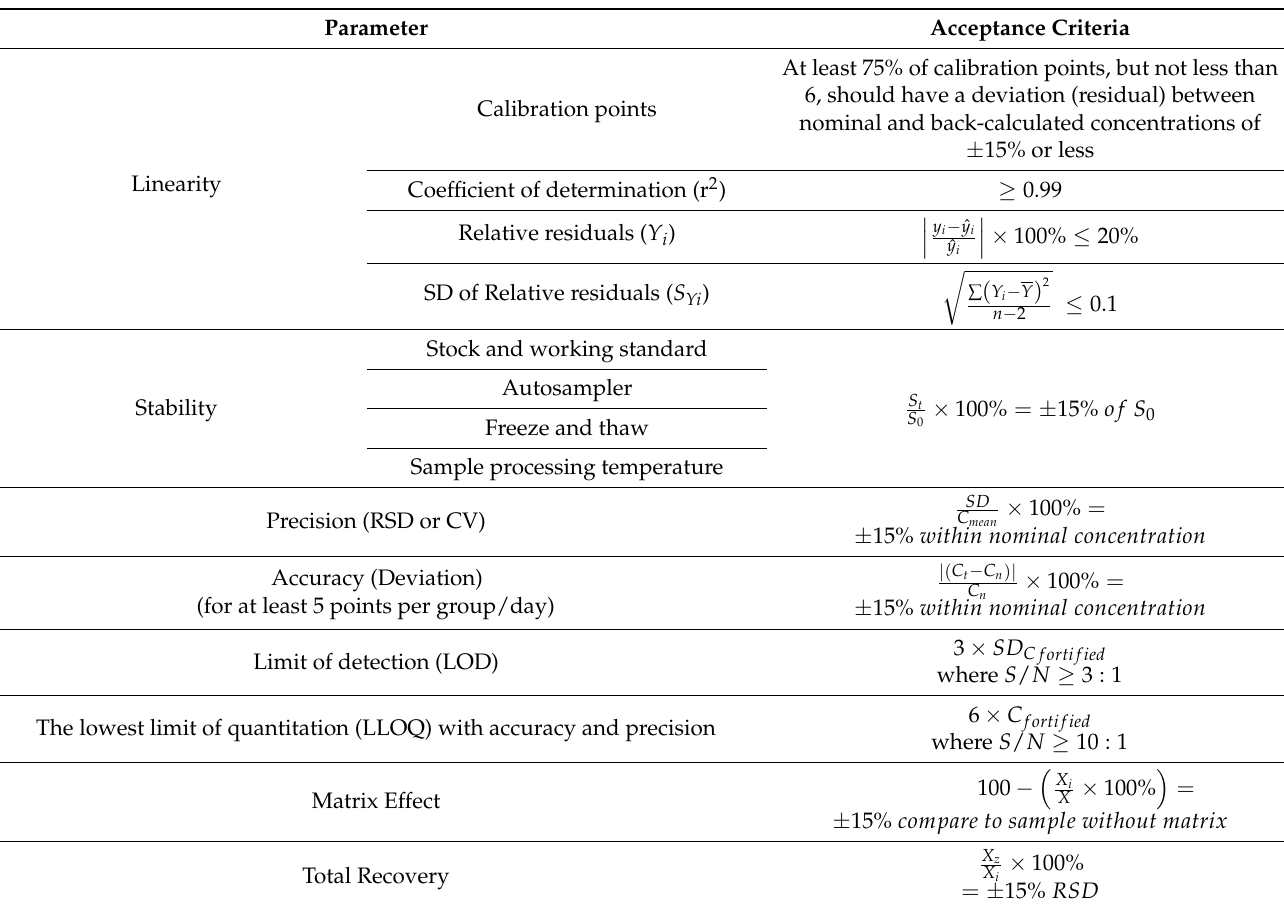
Table 2. Methods of calculation and acceptance criteria for validation